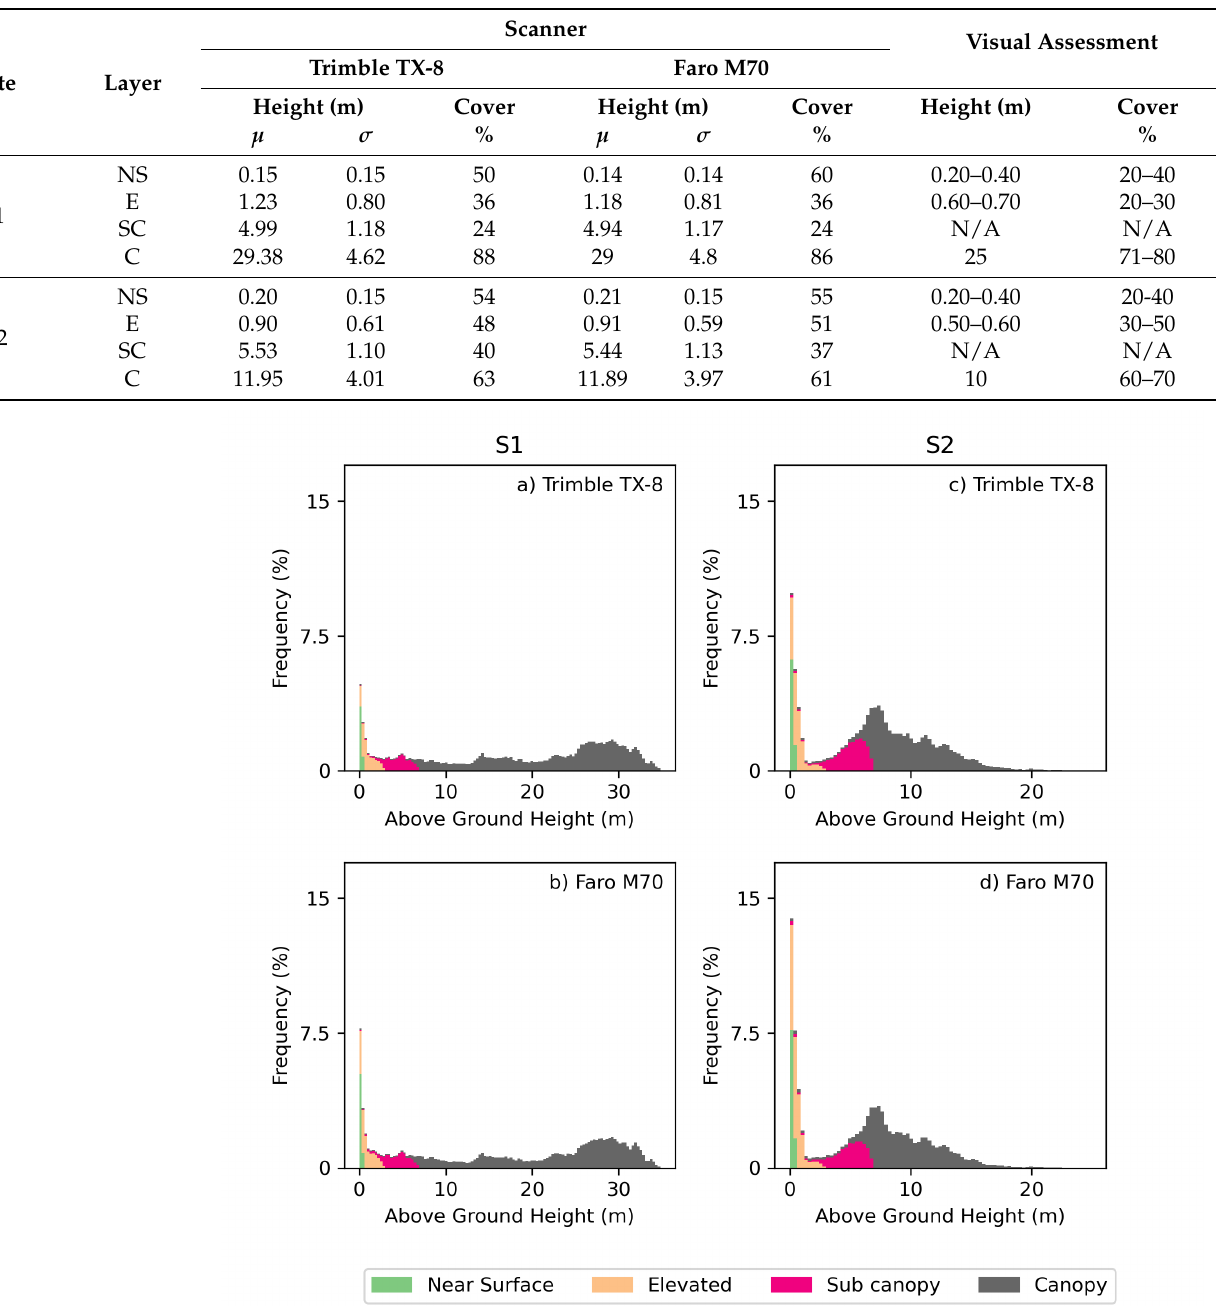
Table 2. Height ( µ : mean, and σ : standard deviation) and cover of each fuel layer produced by the merged scans from each scanner at the two sites.